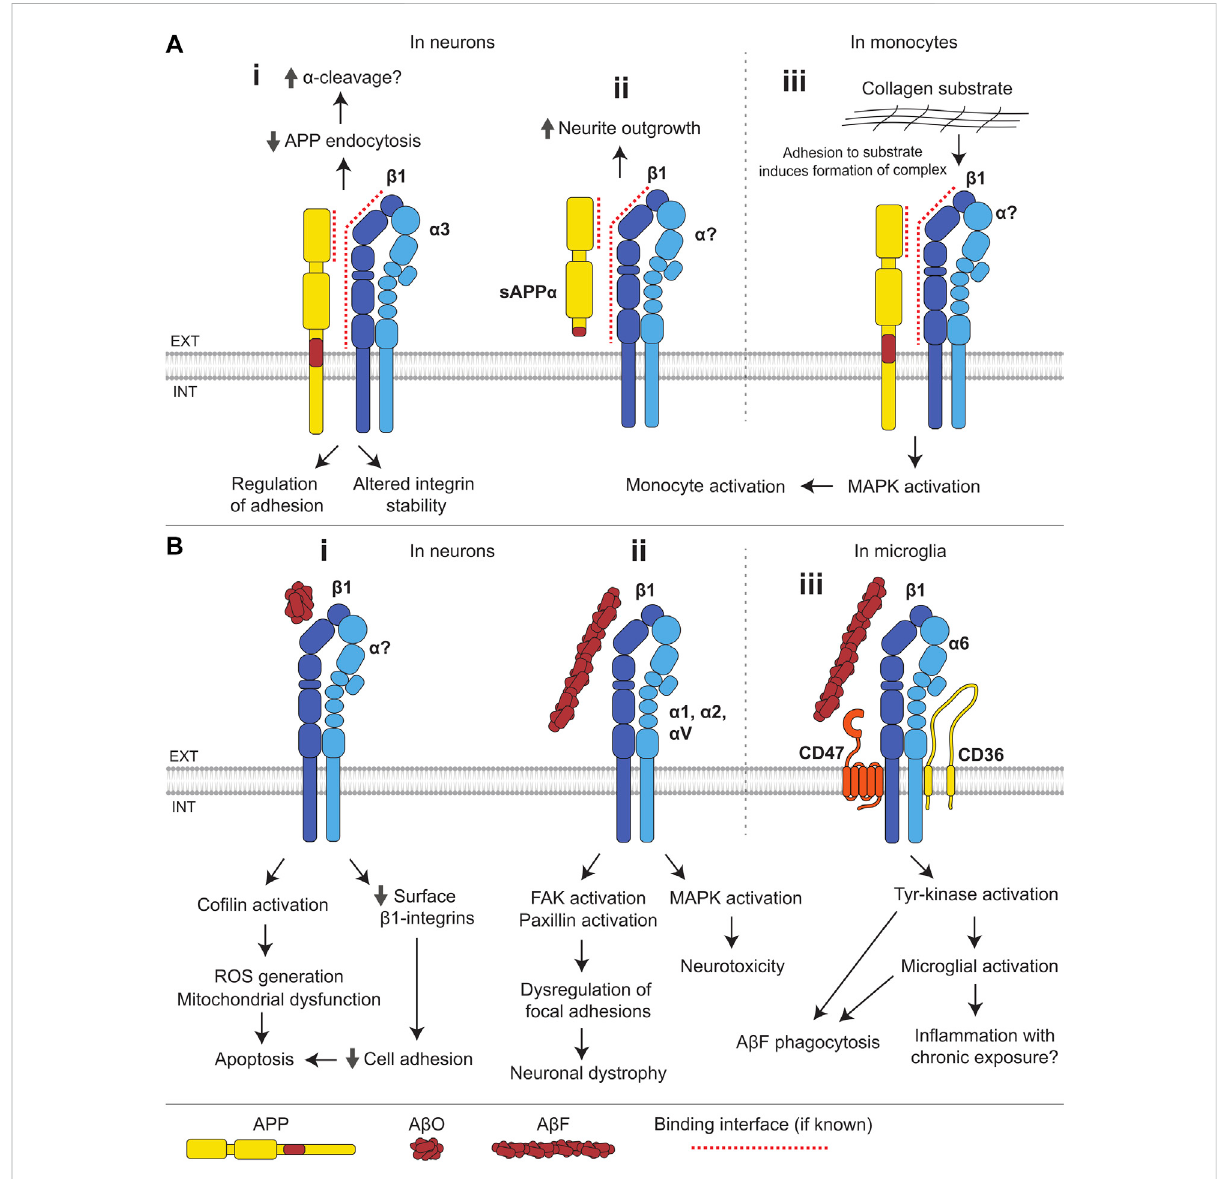
FIGURE 4 Interactions ofintegrins with APP and A β . (A) (i) The E1 domain ofAPP interacts with β 1-and α 3-integrins. Integrinssuppress endocytosis of APP and thereby may facilitate its α -cleavage. APP in fl uences integrin stability and integrin-dependent adhesion. (ii) In neurons, sAPP α binds to β 1- integrins and induces neurite outgrowth. (iii) In monocytes, adhesion to a collagen substrate induces the formation of an APP- β 1-integrin complex, whichactivatesMAPKsignalingresultinginmonocyteactivation. (B)(i) Inneurons,bindingofA β Osto β 1-integrinsleadstoareductioninthecell surface levels of β 1-integrins and compromised cell adhesion, and results in activation of the f-actin severing protein, co fi lin, mitochondrial dysfunction and ROS generation, leading to apoptosis. (ii) A β Fs bind several integrin subunits ( β 1, α 1, α 2, and α V) and induce MAPK activation and neurotoxicity.BindingofA β Fto β 1-integrinalsoinducesFAKandpaxillinactivation,leadingtodysregulationofintegrin-mediatedfocaladhesionand contributing to neuronal dystrophy. (iii) In microglia, A β Fs bind to a receptor complex composed of α 6 β 1-integrin, CD47, and CD36, and induce tyrosine-kinase activation, stimulating A β F phagocytosis and microglial